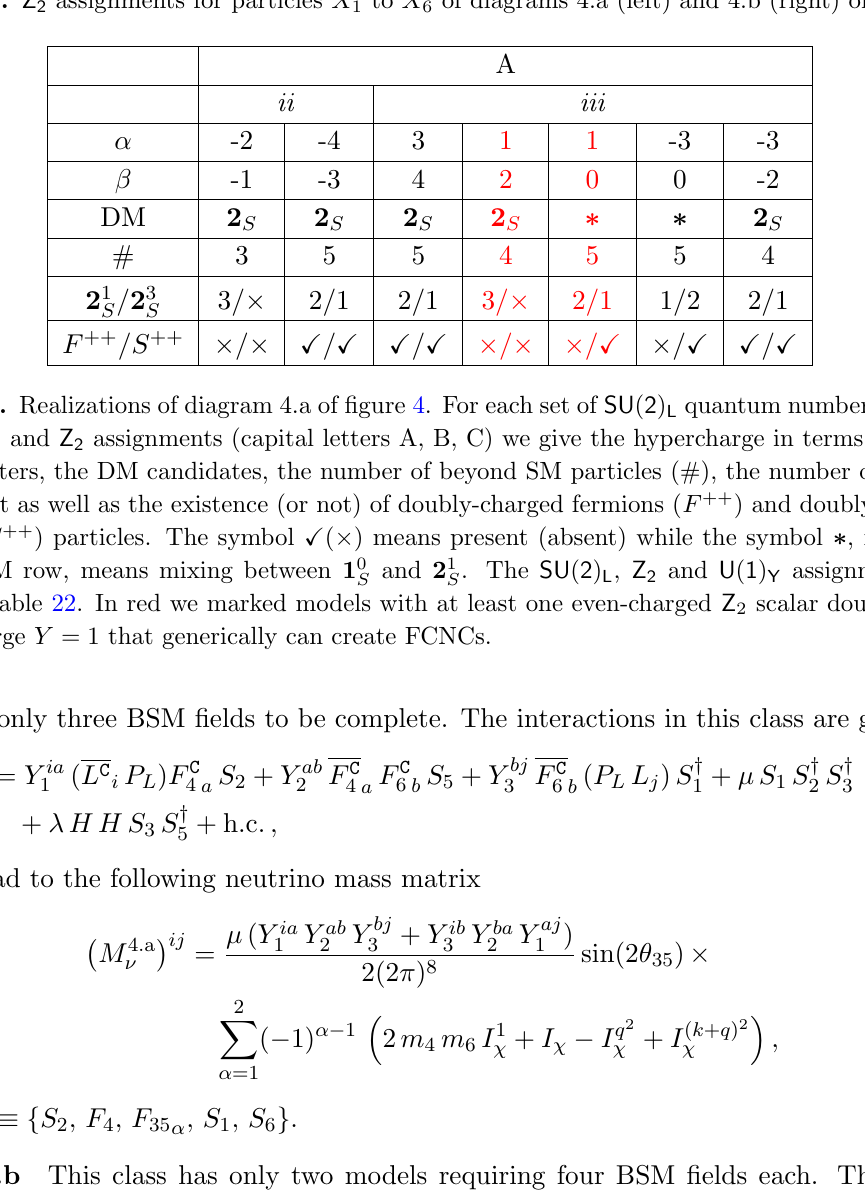
Table 23. Z 2 assignments for particles X 1 to X 6 of diagrams 4.a (left) and 4.b (right) of (cid:12)gure 4.